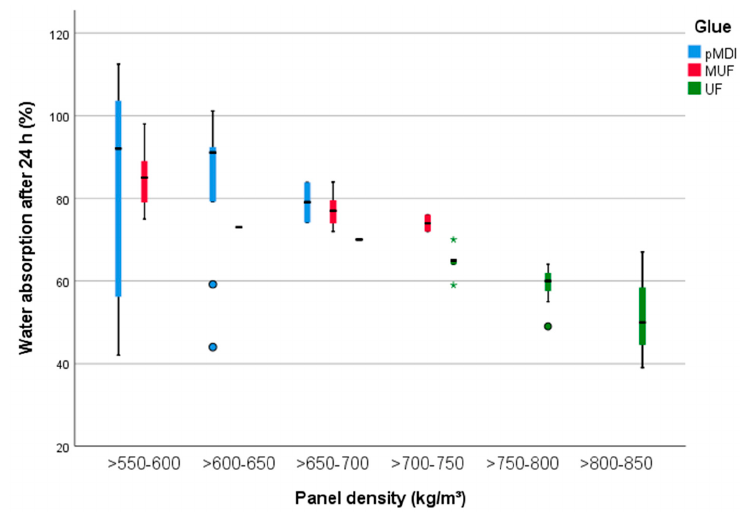
Figure 9. Water absorption after 24 h of the 15 mm PB samples with densities between 500 and 850 kg/m³ and glued with pMDI, UF and